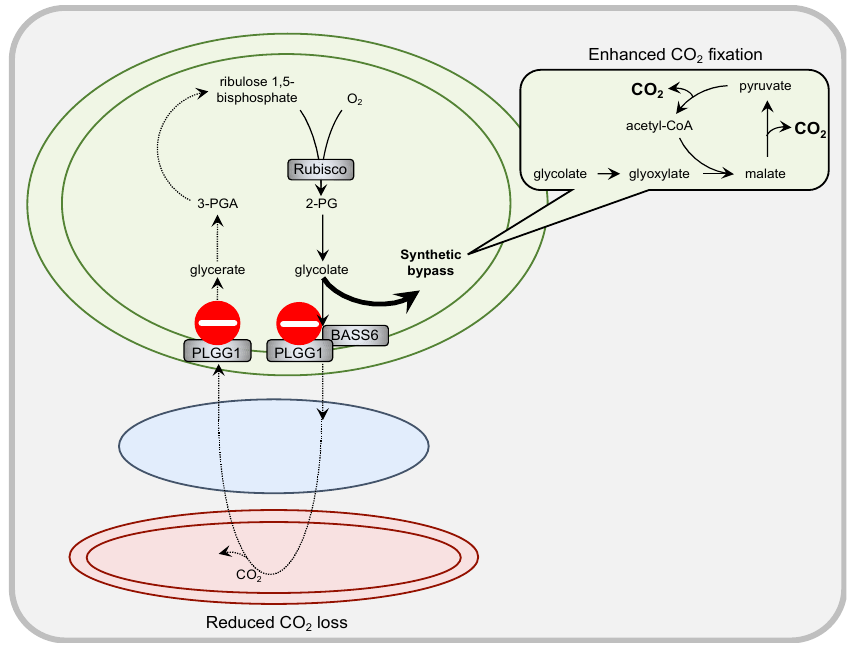
Figure 2. Significance of the plastidial transporter PLGG1 in anticipated flux distribution between native and synthetic route by South et al. [77] in PR metabolism. Silencing of the plastidial glycolate/glycerate transporter PLGG1 allows rerouting of major metabolite flux into the synthetic bypass. In this way, a large portion of the carbon contained in glycolate is released as CO 2 in close proximity to Rubisco within the chloroplast, thus enhancing CO 2 fixation. At the same time, CO 2 loss is reduced since less glycolate continues the native PR route with subsequent mitochondrial decarboxylation reaction.